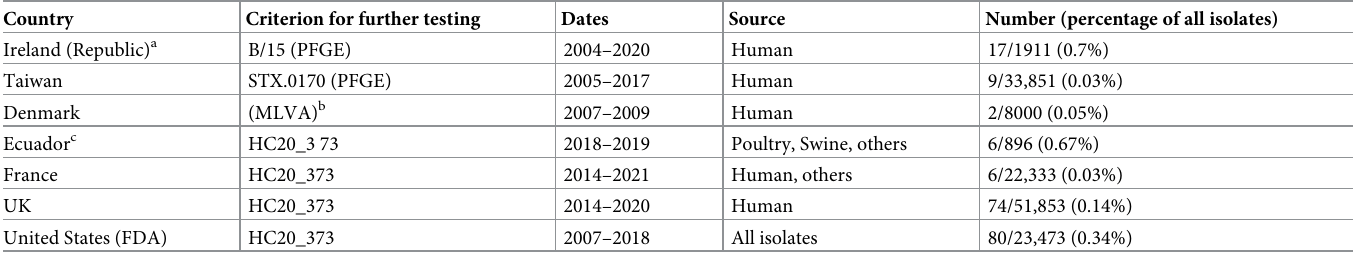
Table 3. Proportions of natural HC20_373 isolates in individual countries.